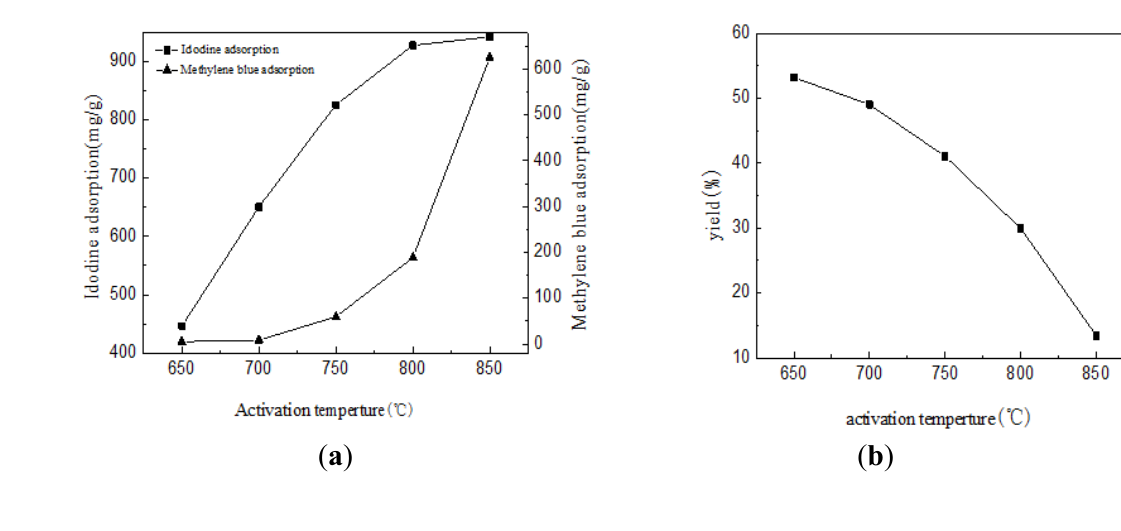
Figure 2. The iodine, methylene blue (MB) ( a ) adsorption and ( b ) yield of